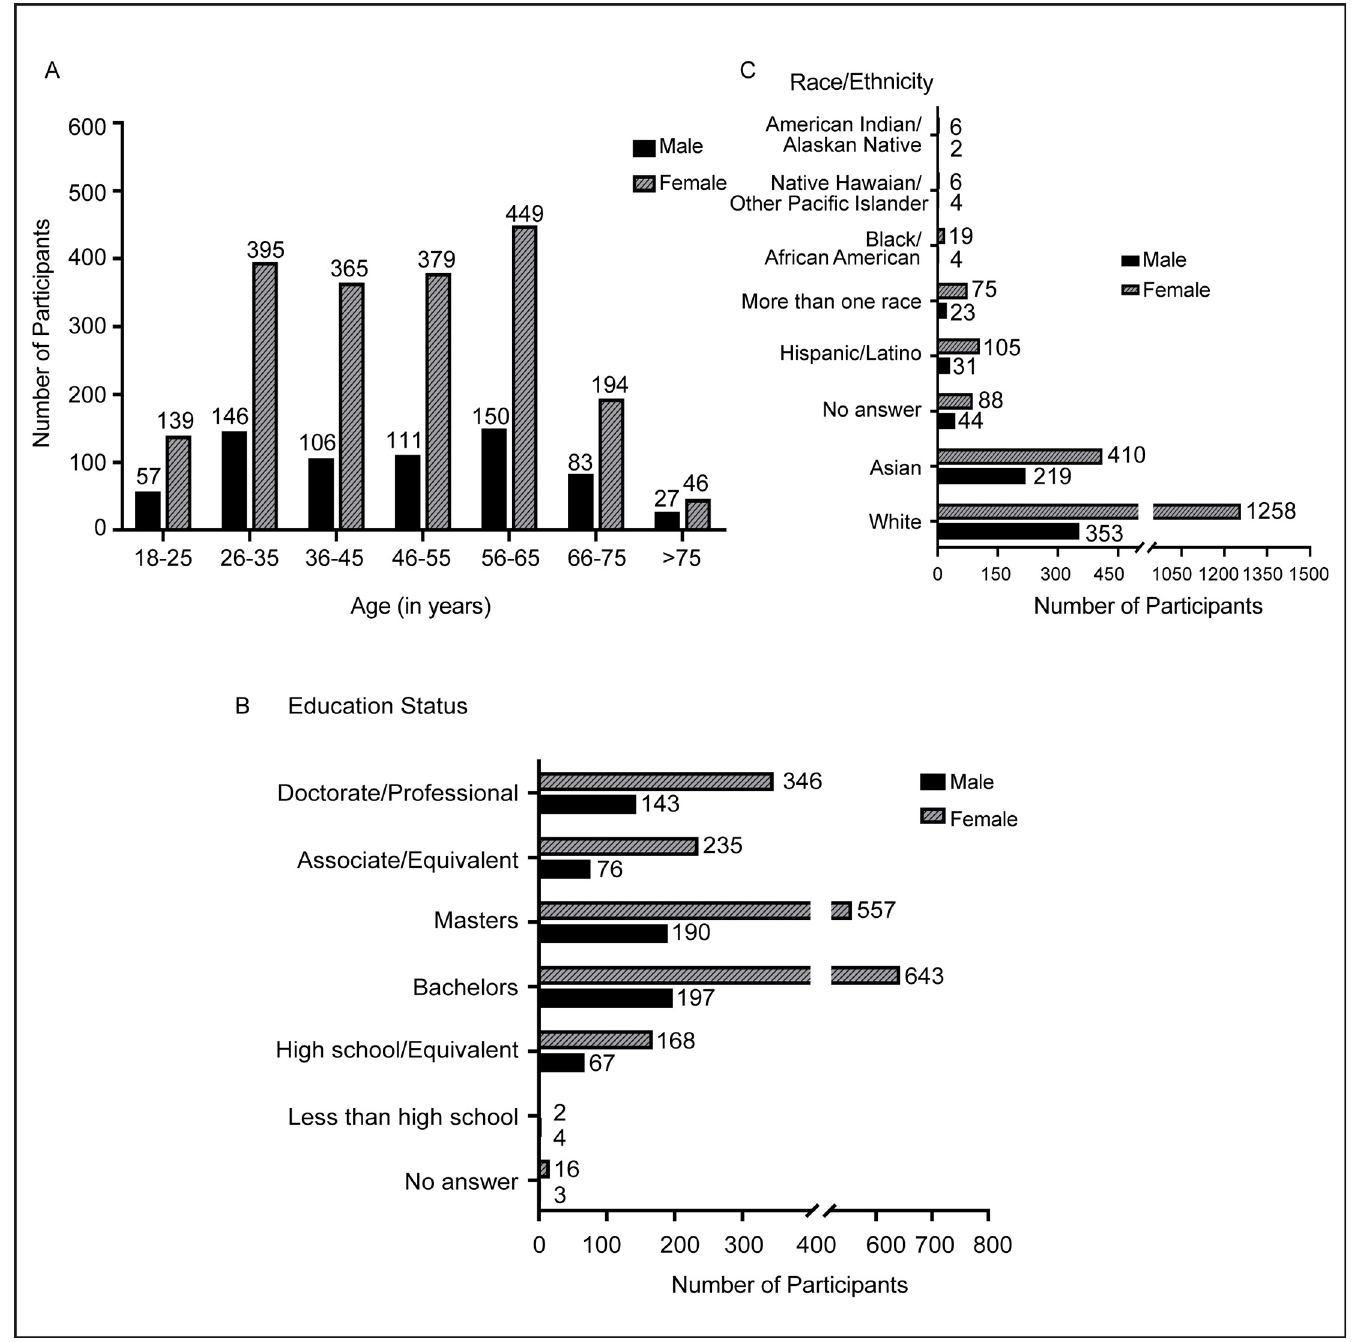
Fig 1. Graphical representation of demographics of the study participants. Age-distribution of the participants. B. Educational status of the participants. C. Racial/ethnic background of the participants. All the plots are further subdivided by gender. https://doi.org/10.1371/journal.pone.0255399.g001 having a bachelor’s degree or higher (Fig 1B). The survey takers had the following racial/ethnic identities: White, Asian, Hispanic or Latino, Black or African American and “others” such as Native Americans, Hawaiians, Pacific Highlanders, Alaskan Native, or some with more than